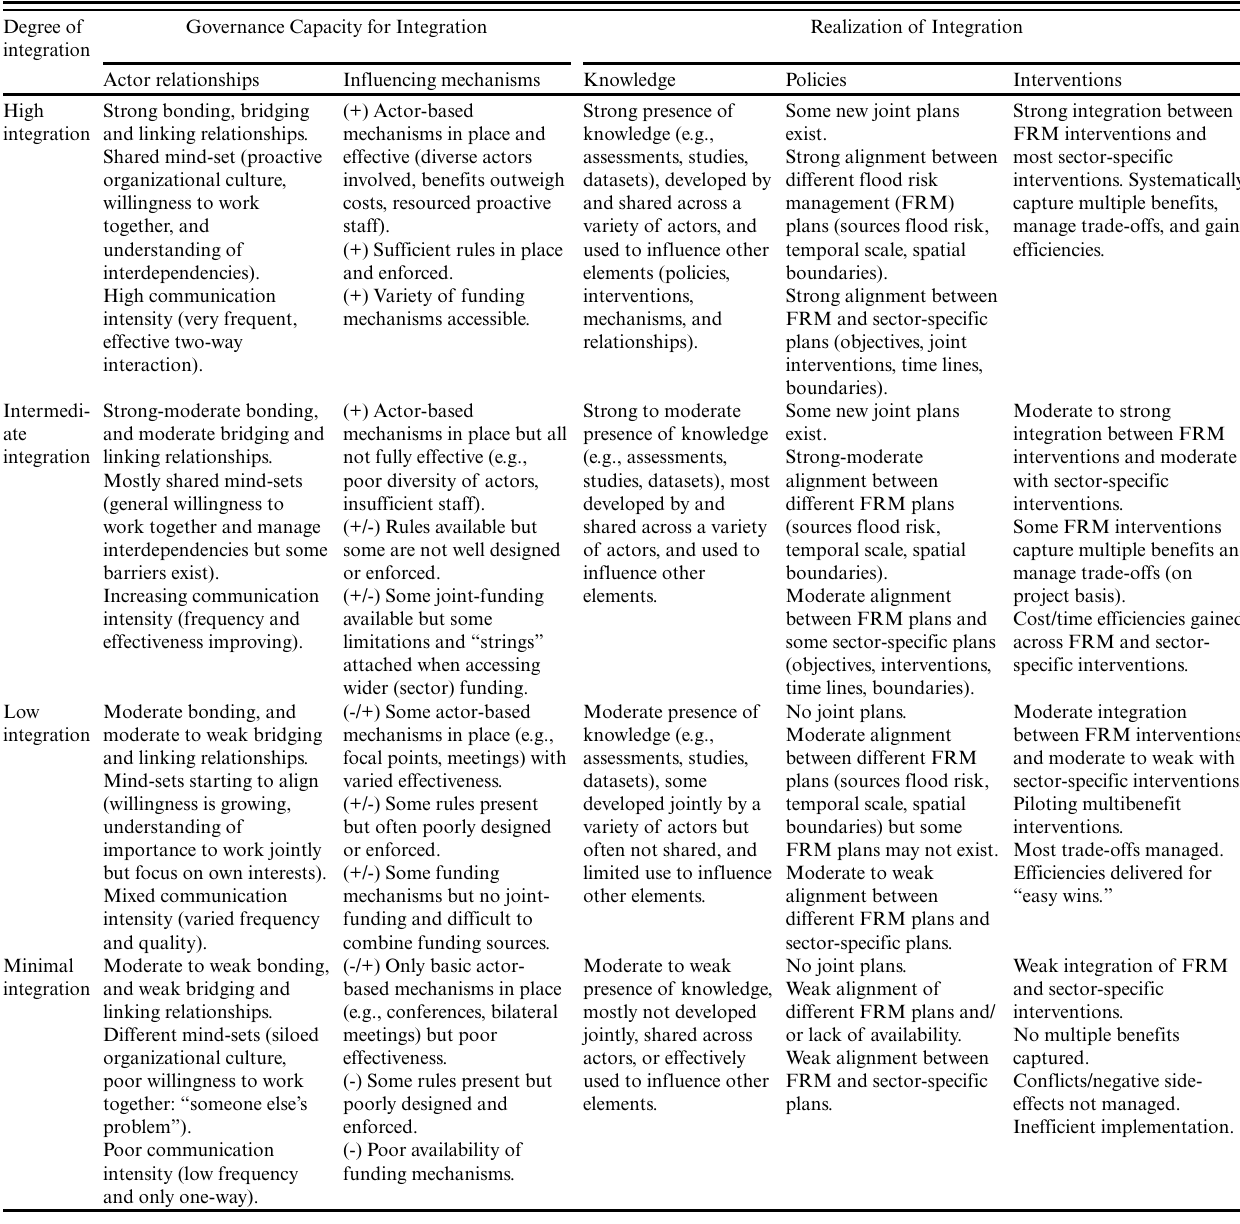
Table 1 . Assessment table for identifying the degree of integration. Degree of Governance Capacity for Integration Realization of Integration integration Actor relationships Influencing mechanisms Knowledge